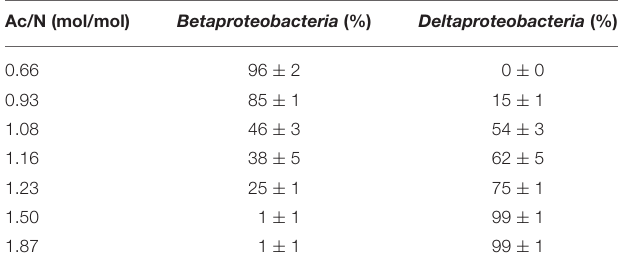
TABLE 6 | Relative abundances of the Betaproteobacteria and Deltaproteobacteria in the steady state populations obtained from cell counts of the FISH analyses.